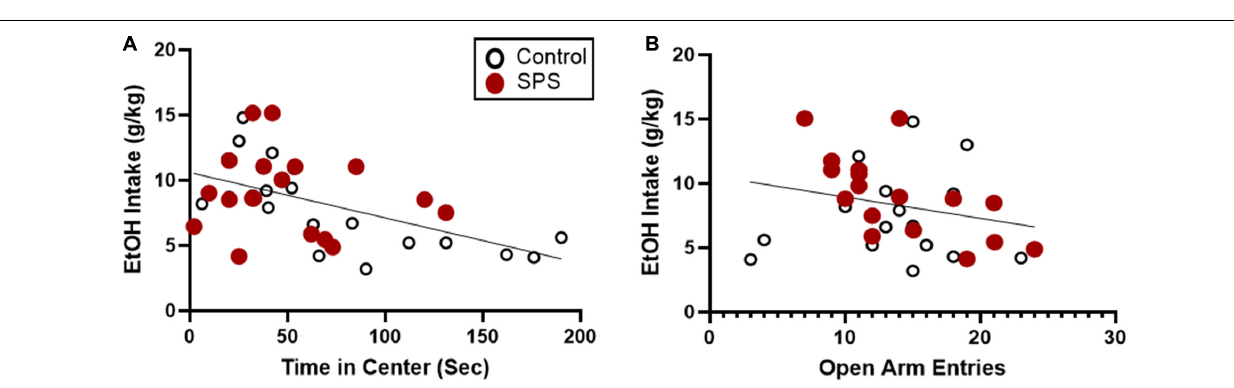
FIGURE 5 | Correlation analyses between ethanol consumption during weeks 6–8 (sessions 16–24) and anxiety-like behaviors on the open field test and elevated plus maze. Both controls and SPS-exposed rats ( N = 33) were included in the correlation analyses. (A) Time in center during open field testing was a significant indicator of ethanol consumption with a large effect size (** P = 0.0026, r = –0.5076). (B) Open arm entries during elevated plus maze testing was not significantly correlated with ethanol consumption ( P > 0.05, r = –0.2431).